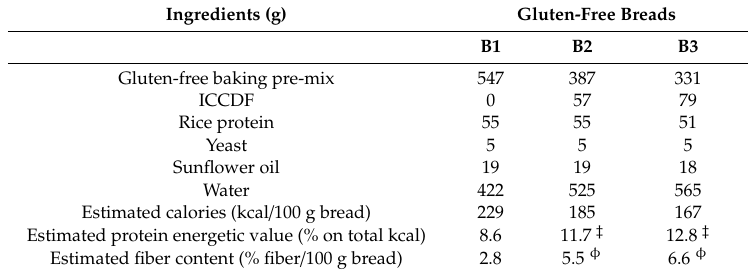
Table 5. Bread formulations of control bread (B1), bread with 3% isolated co ff ee cascara dietary fiber (B2) and bread with 4.5% isolated co ff ee cascara dietary fiber